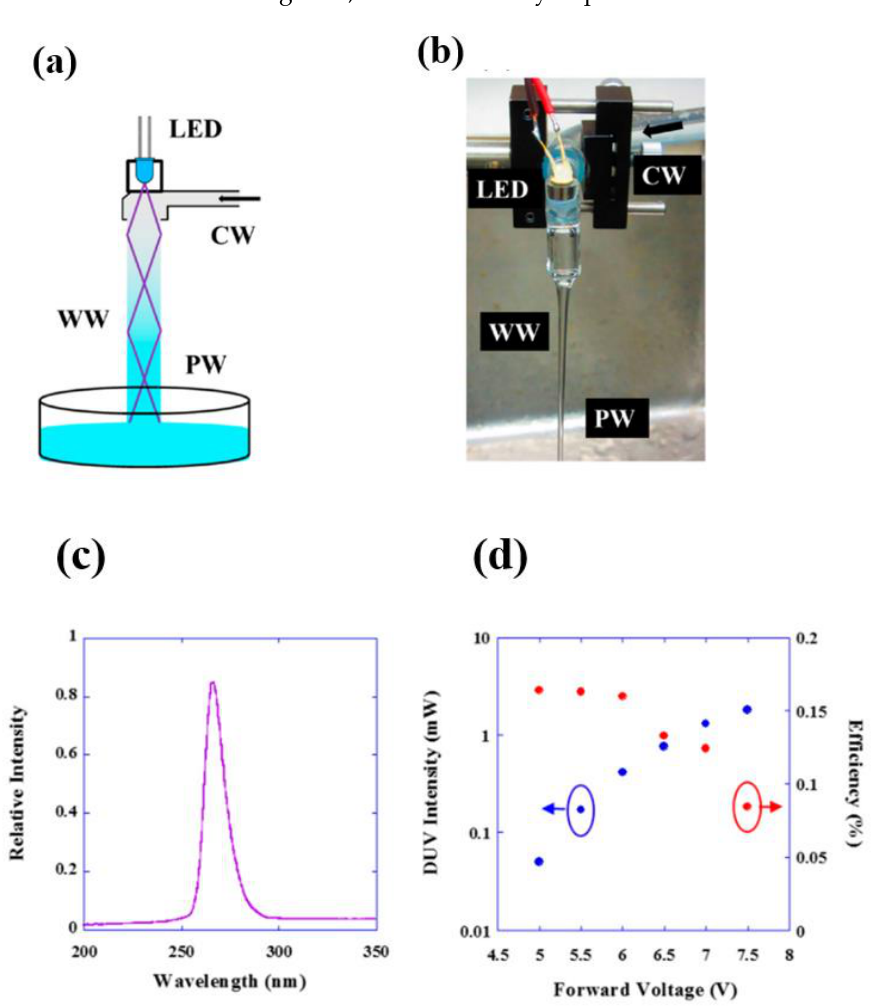
Figure 9. ( a ) Schematic diagram and ( b ) photograph of the water waveguide purification system, ( c ) emission spectrum of the deep-ultraviolet-LED, and ( d ) DUV intensity (blue circles) and wall-plug efficiency (WPE) (red circles) versus forward voltage [99].